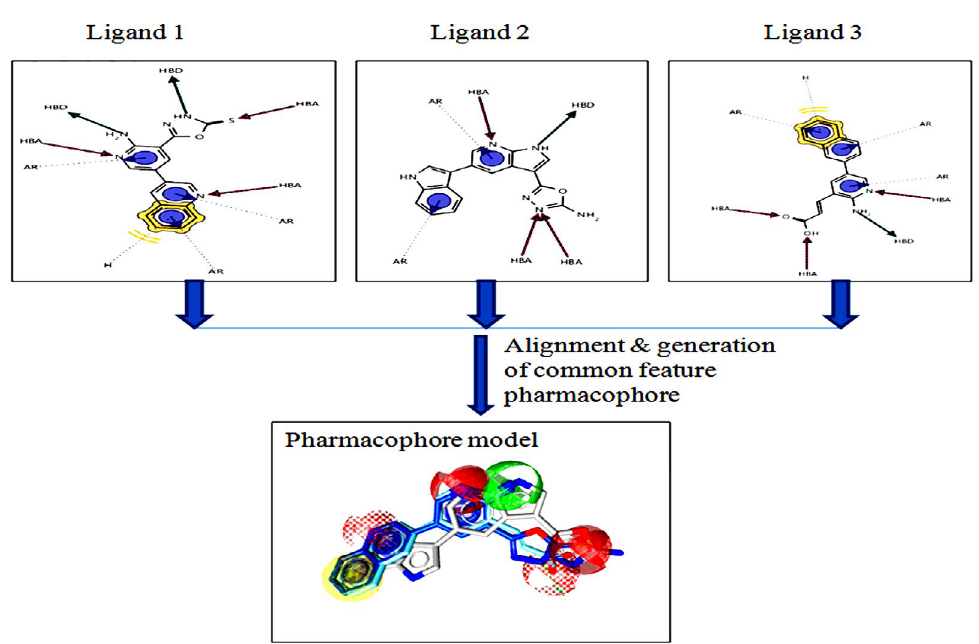
Fig. 10. Representation of ligand-based Pharmacophore modeling. Table 3. Structure-based pharmacophore modeling software S. No.